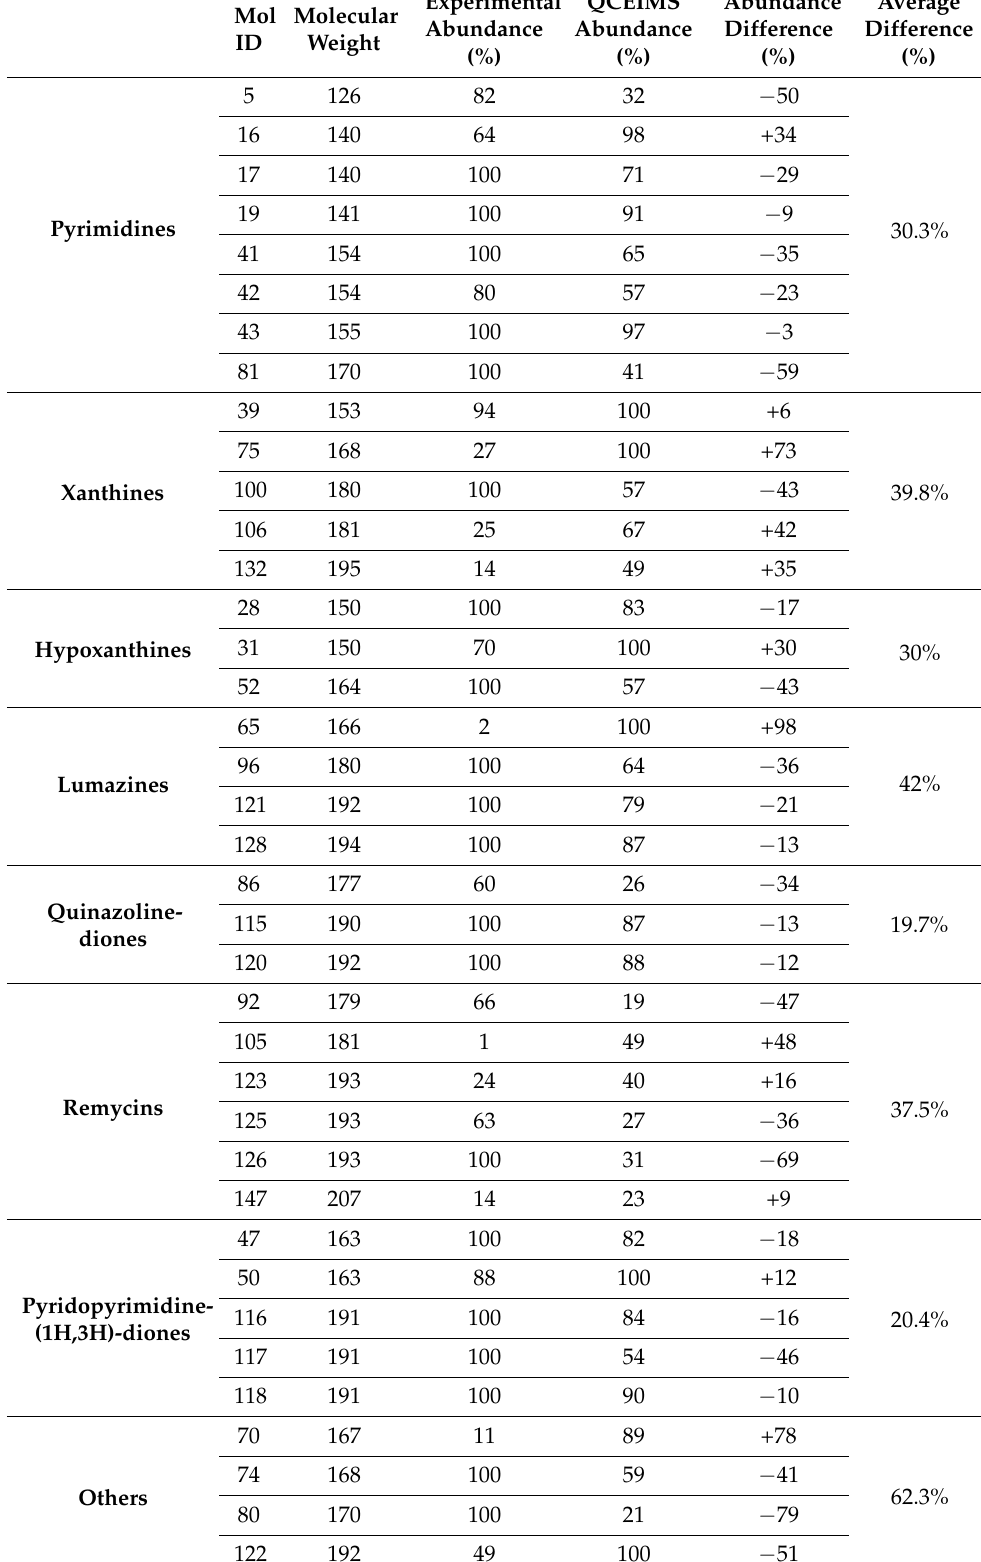
Table 2. Differences in the relative abundances of the molecular ions (as percent of the base peak in each mass spectrum) comparing 80 QCEIMS spectra in the 12 subclasses of purines and pyrimidines to molecular ions of NIST 17 experimental